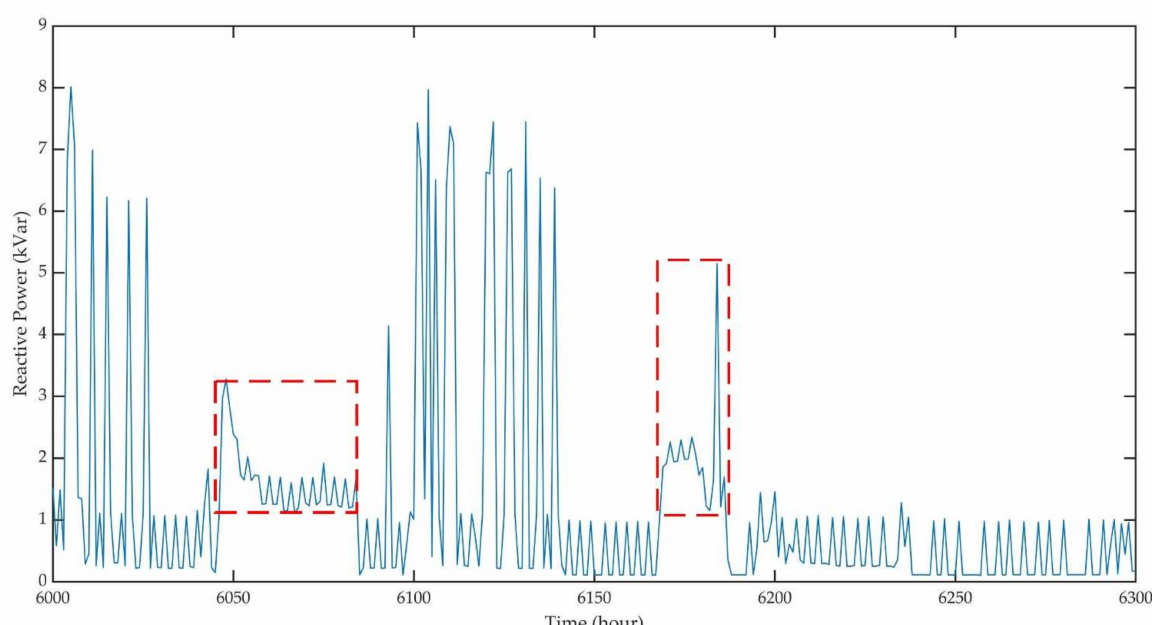
Figure 1. Data display of reactive power (part of the prefecture-level reactive power data of a city in East